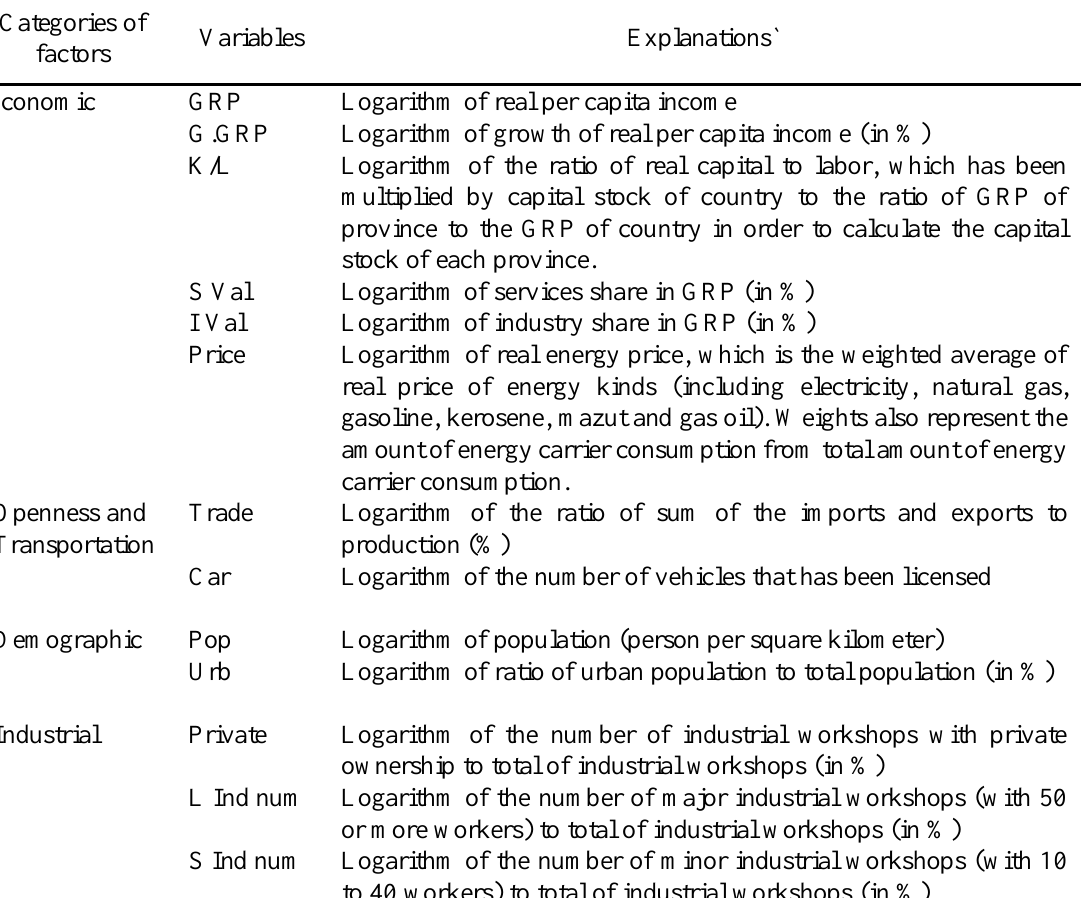
Table 2. Variables used in study Categories of